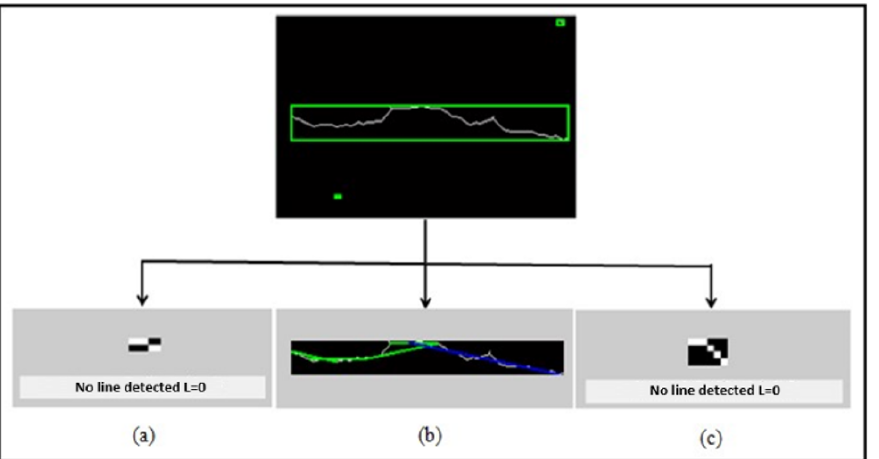
Figure 11. Choice of the best Hough line ( a , c ) No line detected, ( b ) Hough line. The green box illustrates the shape of the crack approximated using a